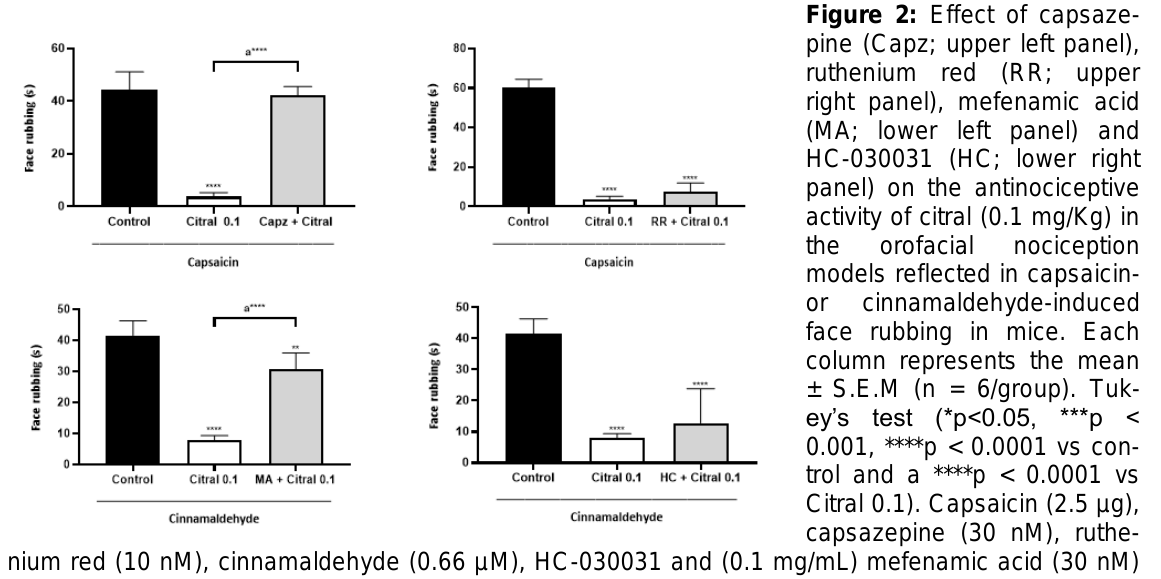
Figure 2: Effect of capsaze- pine (Capz; upper left panel), ruthenium red (RR; upper right panel), mefenamic acid (MA; lower left panel) and HC-030031 (HC; lower right panel) on the antinociceptive activity of citral (0.1 mg/Kg) in the orofacial nociception models reflected in capsaicin- or cinnamaldehyde-induced face rubbing in mice. Each column represents the mean ± S.E.M (n = 6/group). Tuk- ey’s test (*p<0.05, ***p < 0.001, ****p < 0.0001 vs con- trol and a ****p < 0.0001 vs Citral 0.1). Capsaicin (2.5 µg), capsazepine (30 nM), ruthe-